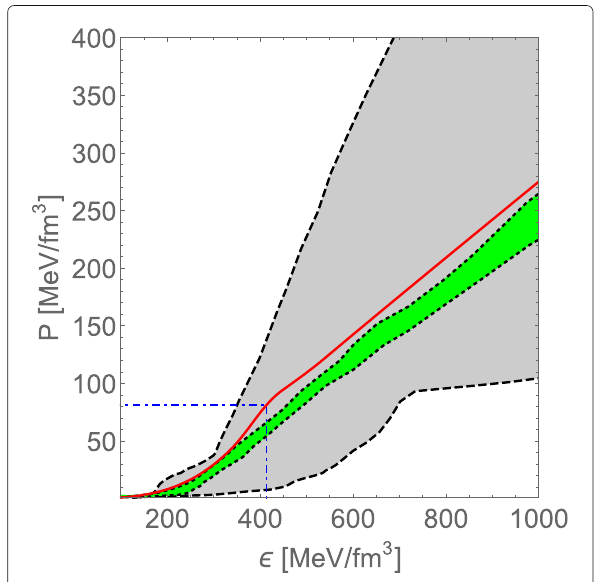
Fig. 12 Comparison of ( P /(cid:19)) between the PCM velocity and the band from [34]. The gray band is from the causality and the green band from the conformality. The red line is the PCM prediction. The dash-dotted line indicates the location of the topology change